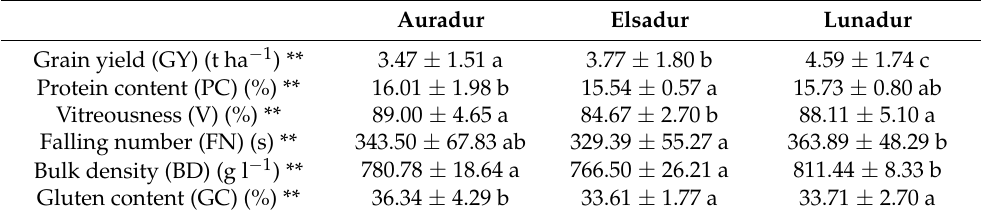
Table 5. Yield components of three durum wheat varieties used in this study. The lower case letters (a, b, c) indicate significant differences among the varieties determined by Tukey’s HSD test, included is also standard deviation ( ± SD). ** α = 0.01 indicate level of